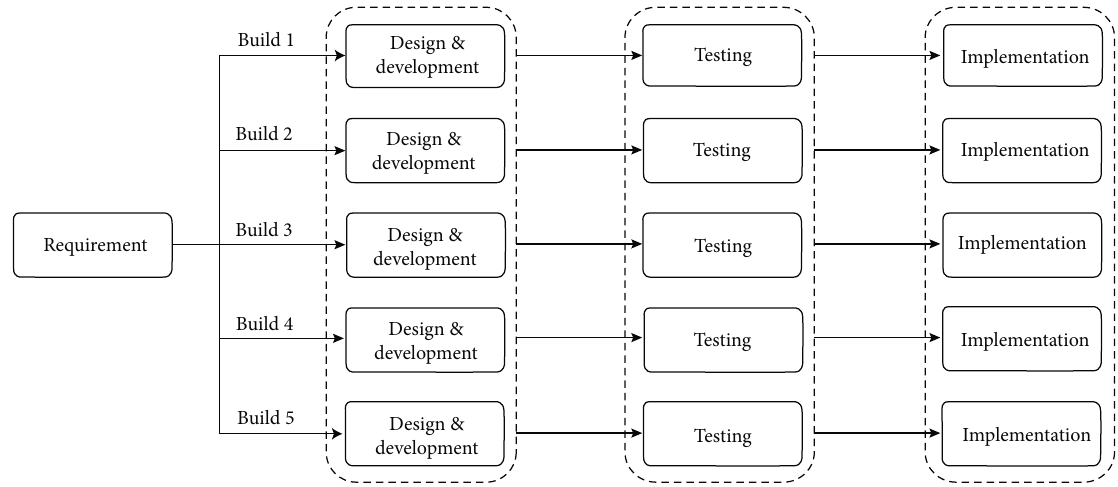
Figure 3: Iterative model design of the proposed system [23].